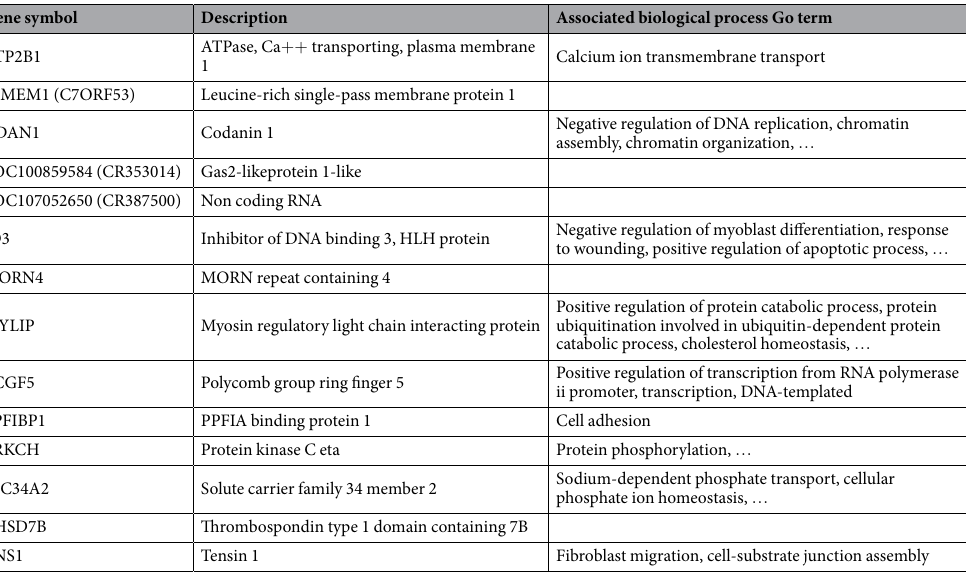
Table 2. List of the 14 genes kept in all 10 fsPLS models fitted to identify predictive biomarkers of chicken breast meat